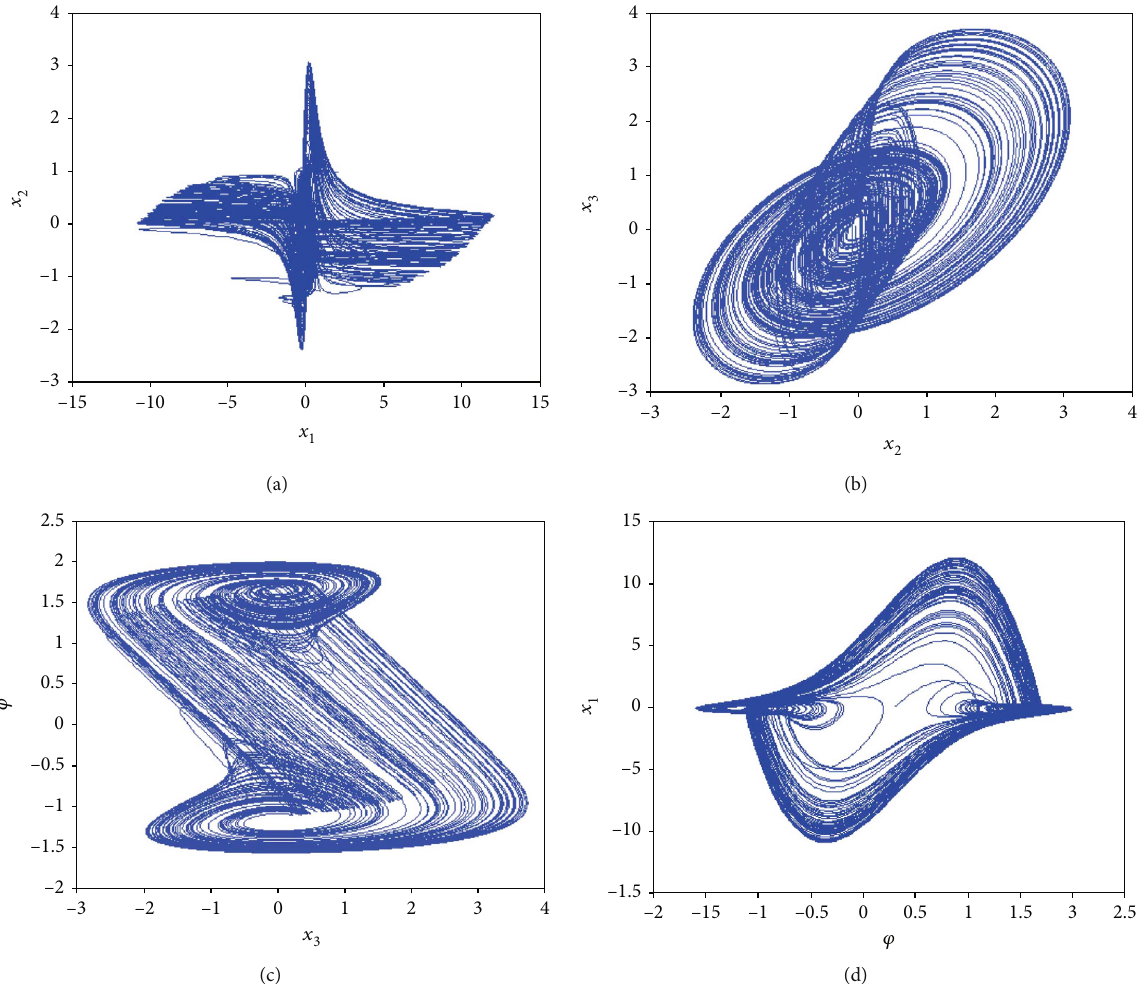
‐ x 1 2 phase diagram, (b)